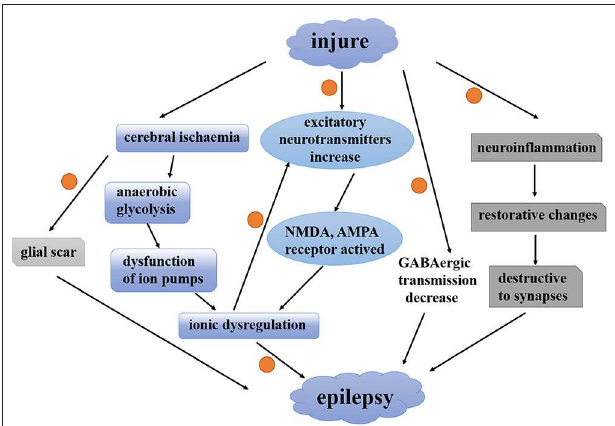
FIGURE 1 | The interaction between astrocytes and epilepsy induced by traumatic brain injury. A contemporary view of how traumatic brain injury induces post-traumatic epilepsy. Orange dots represent sites where astrocytes may be involved in the regulation of post-traumatic epilepsy. NMDA, N-methyl-D-aspartate; AMPA, a-amino-3-hydroxy-5-methyl-4- isoxazolepropionic acid; GABA, γ -aminobutyric